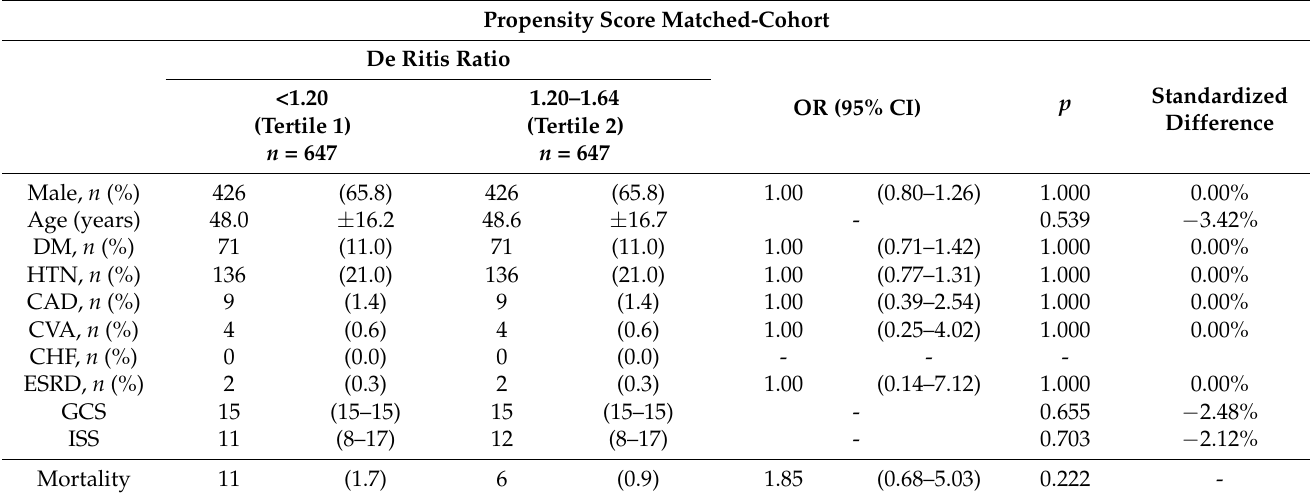
Table 3. Propensity score matched-cohort of patients in the tertile 1 vs. tertile 2 groups. Propensity Score